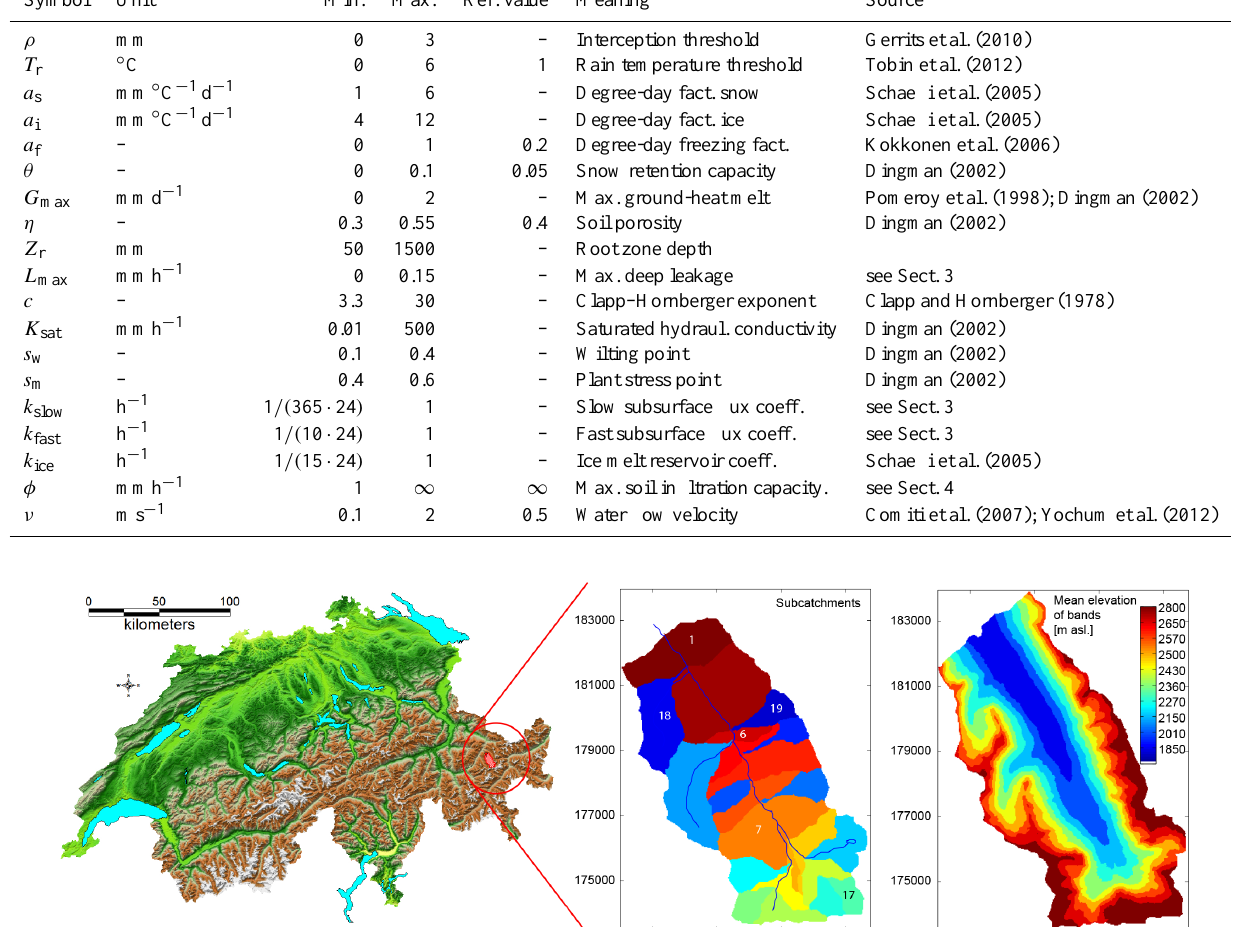
Table 2. Model parameters that have to be calibrated or estimated otherwise with indication of a priori values, a reference value for parameters that are not calibrated here and key references for further details. A total of 12 parameters are calibrated here. The maximum value of the reservoir coefficient is the numerical time step.